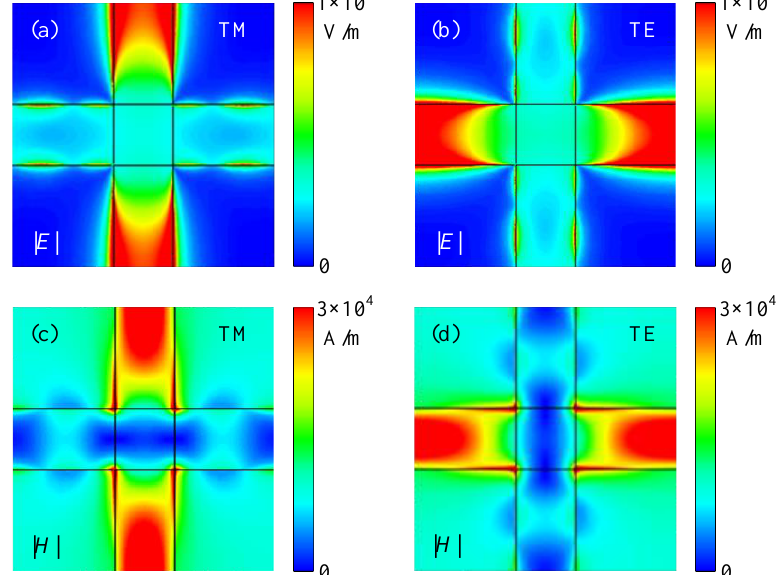
Figure 3. ( a – d ) are the electric field distributions, | E |, and magnetic field distributions, | H |, for TM and TE polarizations of the absorbers with SLDGRAs along the cut-plane on the top graphene layer at 6.85 THz with μ c = 0.3 eV under normal terahertz incidence, respectively.